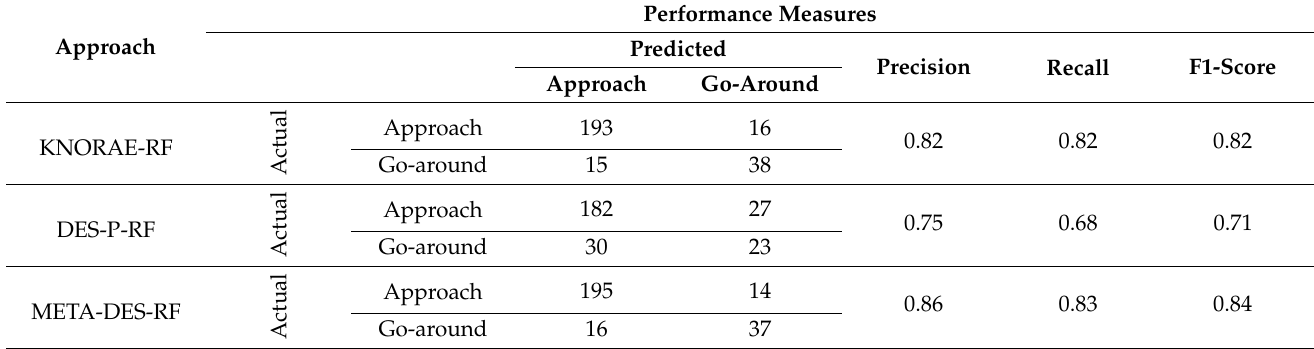
Table 7. Comparison of performance measures of DES algorithms based on the pool of RF.